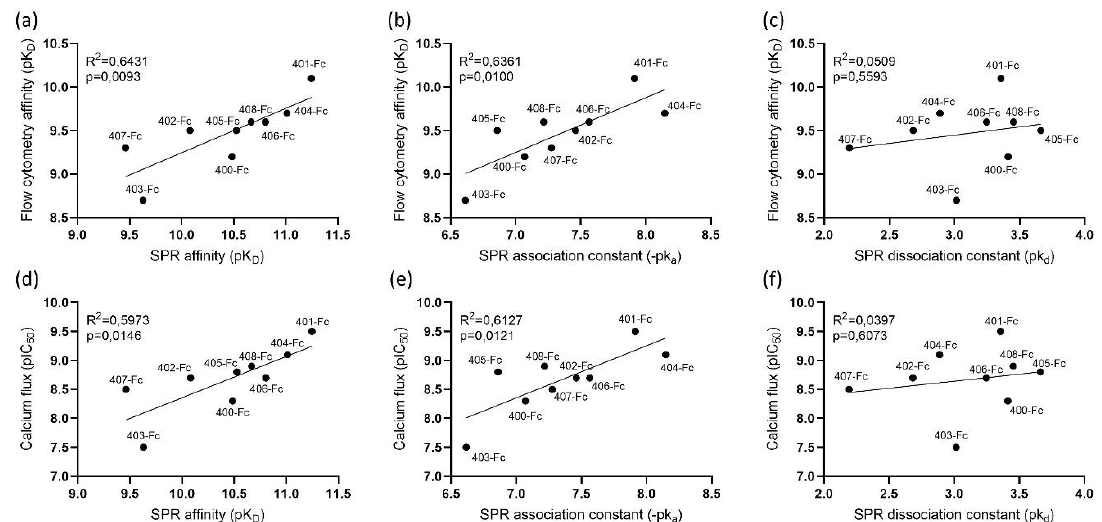
Figure 5. Correlation between surface plasmon resonance (SPR) affinity data with cell-based flow cytometry and calcium mobilization results. Comparisons between ( a ) the affinity (K D ) measured by SPR and flow cytometry; ( b ) the SPR association rate constant (k a ) and the flow cytometry affinity; ( c ) the SPR dissociation rate constant (k d ) and the flow cytometry affinity; ( d ) calcium flux (pIC 50 ) and the SPR affinity; ( e ) calcium flux and the SPR association rate constant; and ( f ) calcium flux and the SPR dissociation rate constant.